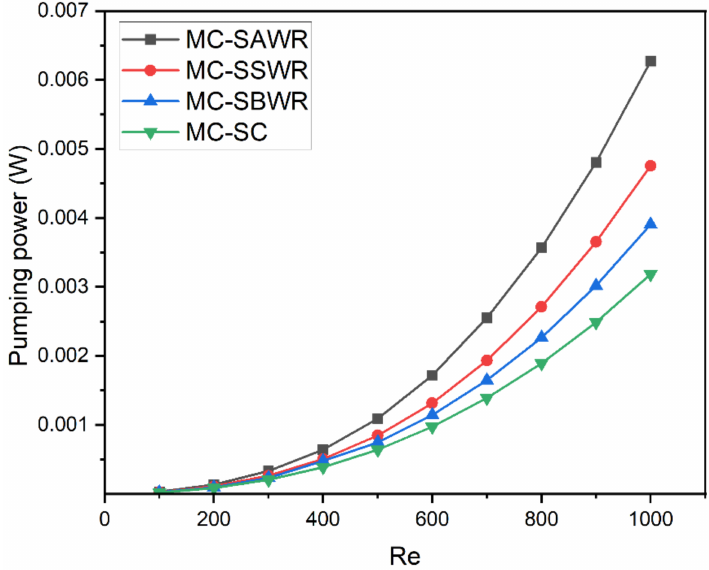
Figure 21. Variation of pumping power with Re for various MCHS